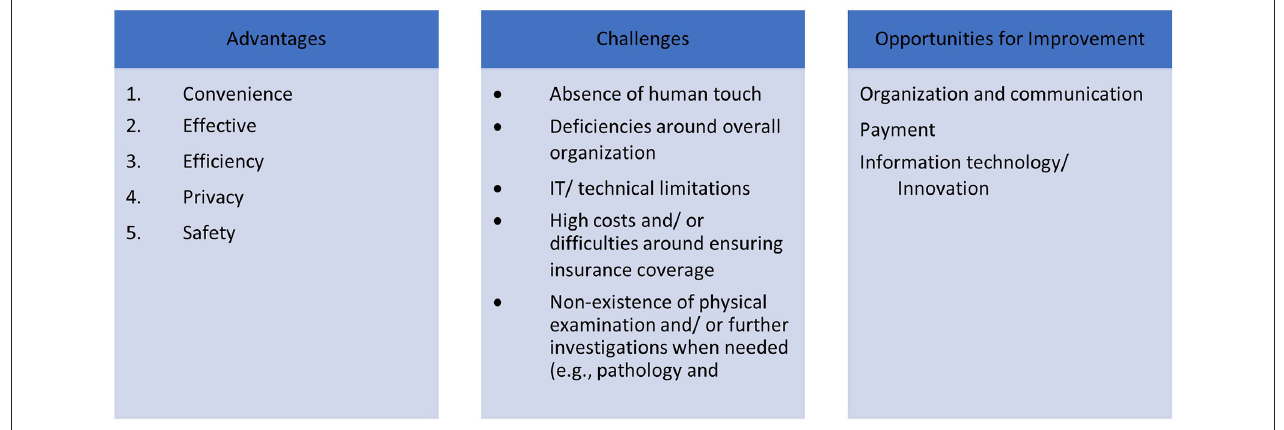
FIGURE 2 | Study’s conceptual framework (illustrating the categories and the themes that emerged from the qualitative analysis).